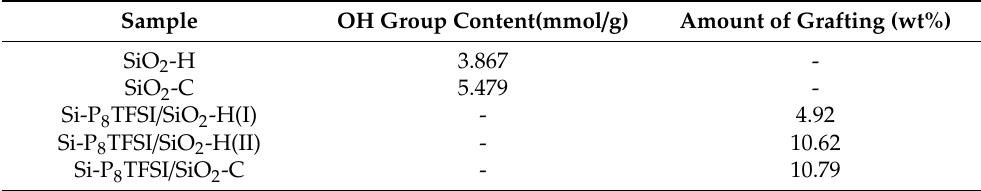
Table 1. Silanol group content for bare silica and the total load of phosphonium ILs onto silica surface determined by TGA techniques.